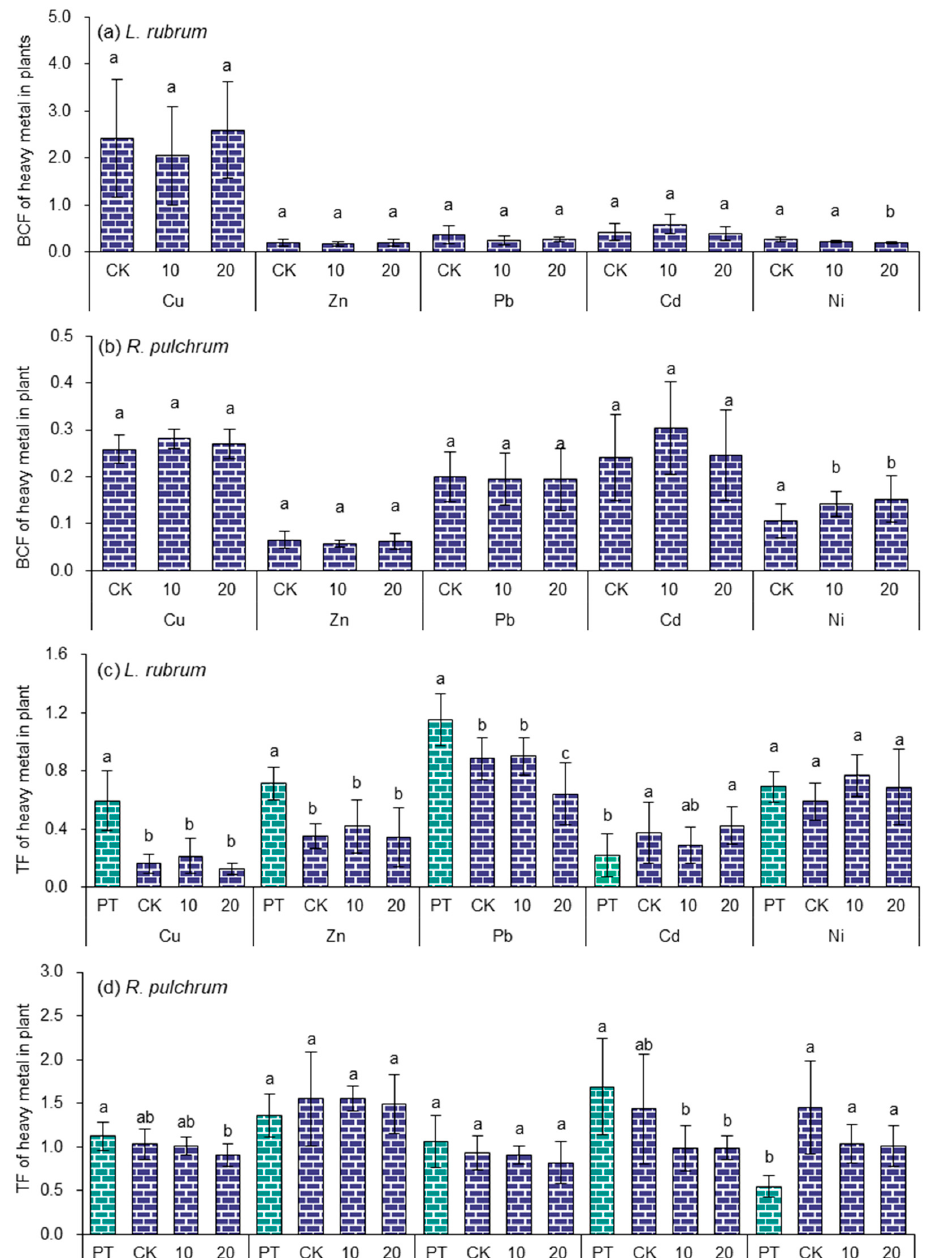
Figure 6. Effects of heavy metal stress and IAA application on BCF and TF values of ornamental plants, ( a , b ) are BCF values of L. rubrum and R. pulchrum ; ( c , d ) are TF values of L. rubrum and R. pulchrum , respectively. Different letters indicate significant differences among the treatments, p < 0.05. The posthoc test was performed with Tamhane method. PT indicates samples of pre-treatment, while CK, 10, and 20 are IAA treatments at 0, 10, and 20 mg L − 1 , respectively. Since the ornamental plants were all obtained from the market, the original soil in- formation was lost, and their initial BCF values could not be calculated. Only the BCF values of the two ornamental plants to heavy metals after transplantation were discussed.